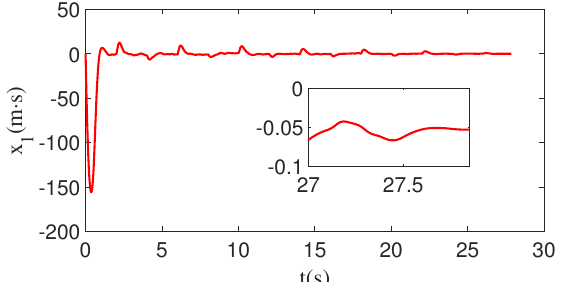
Figure 19. The change of the integral of ZEM with white noise and square wave maneuver.